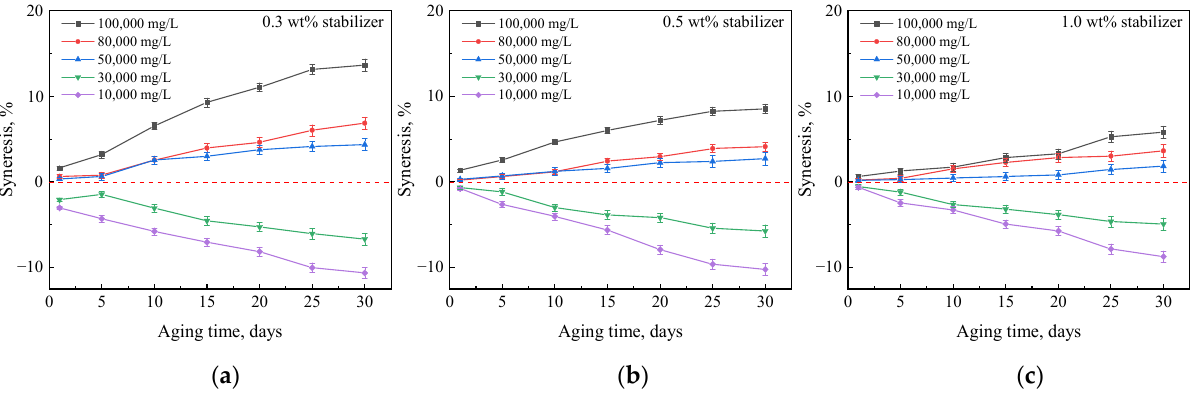
Figure 12. Mass changes of gels prepared with 0.5 wt% AM-AMPS60, 0.5 wt% crosslinker, and different concentrations of stabilizer after aging in brines with different salinities: ( a ) 0.3 wt% stabilizer; ( b ) 0.5 wt% stabilizer; ( c ) 1.0 wt% stabilizer.